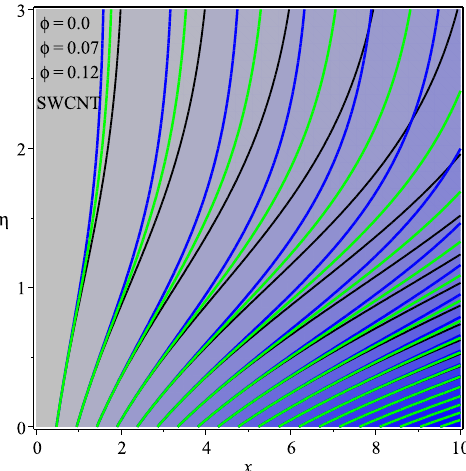
Figure 17. Repercussion of φ with M egt = 0.5, Ω = 1, κ = 2.5, ω = π /3 on stream